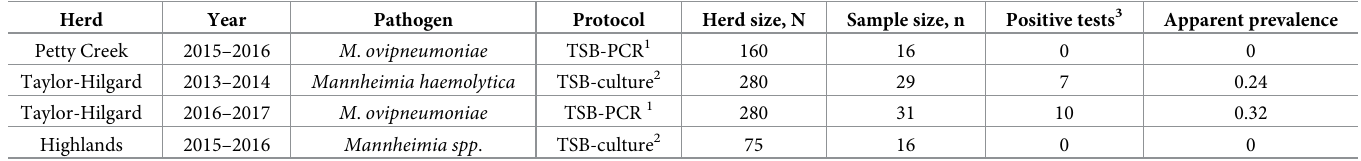
1-2 Specifics of the protocols used for pathogen testing are in S1 Table. 3 Where multiple samples per individual were collected, this refers to the number of individuals with at least one positive detection.